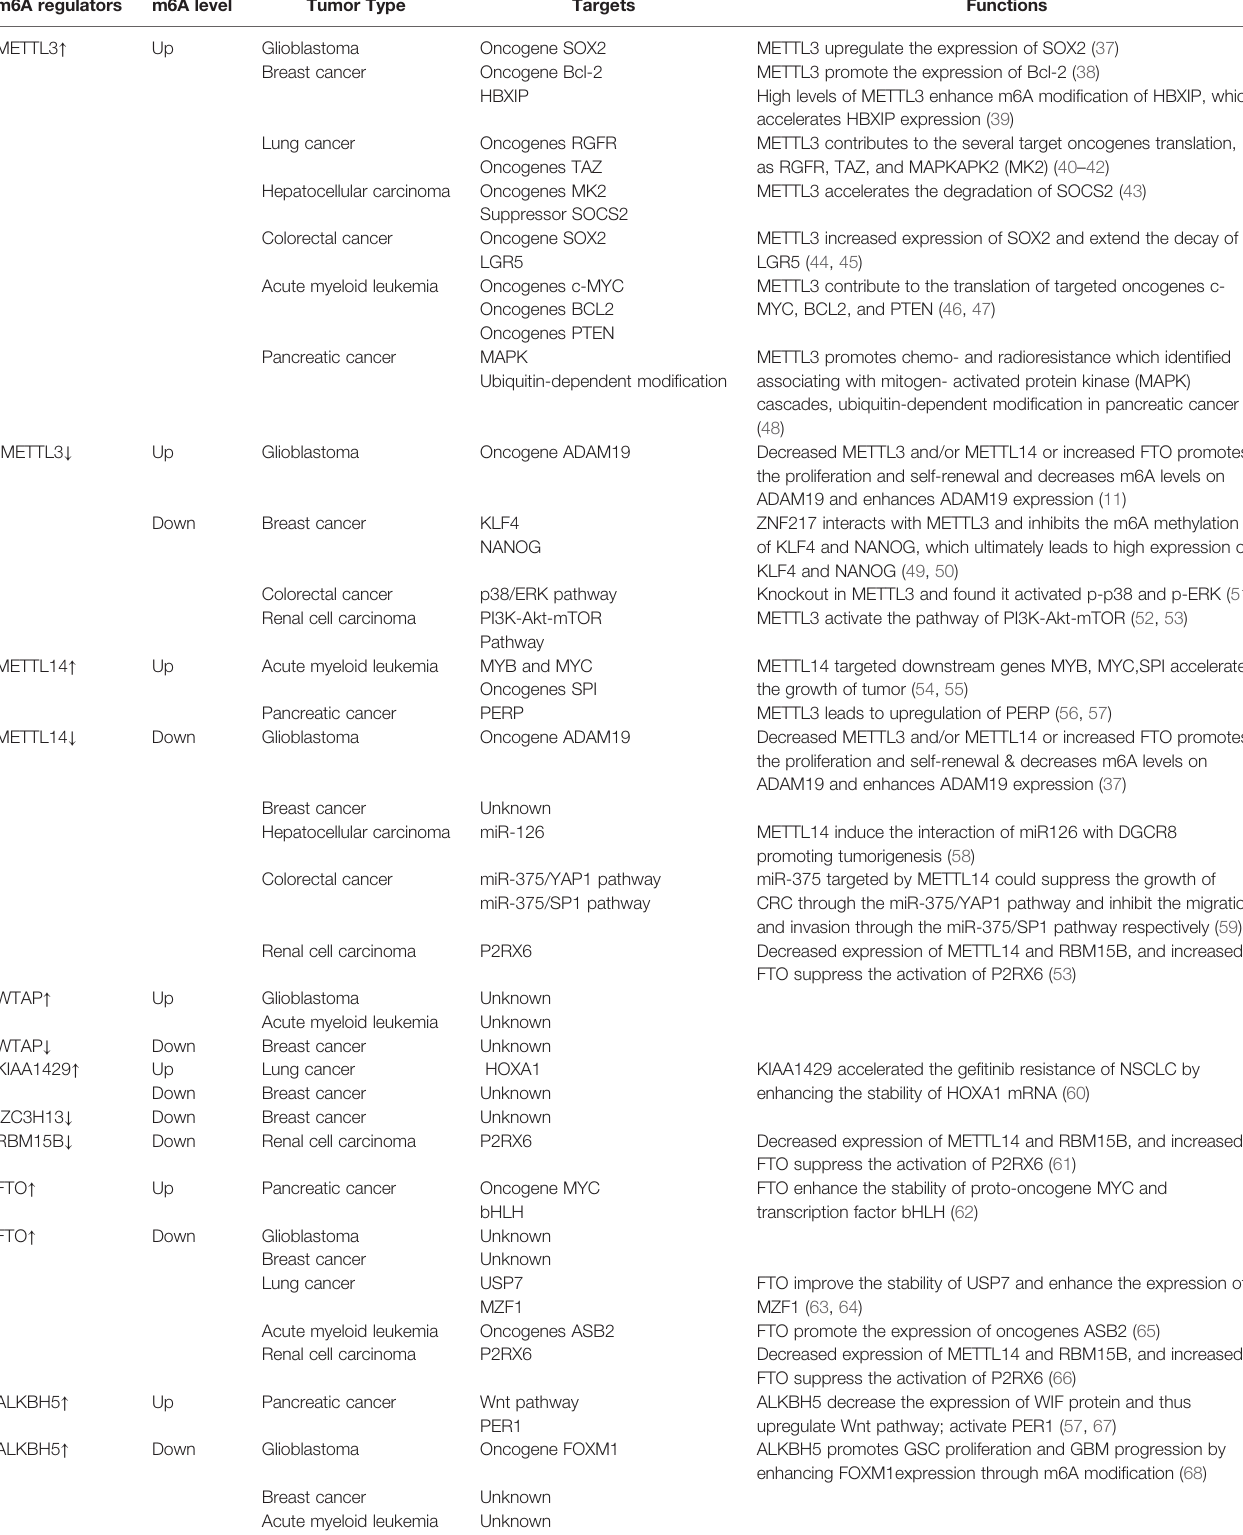
TABLE 1 | List of m6A regulators involved in various